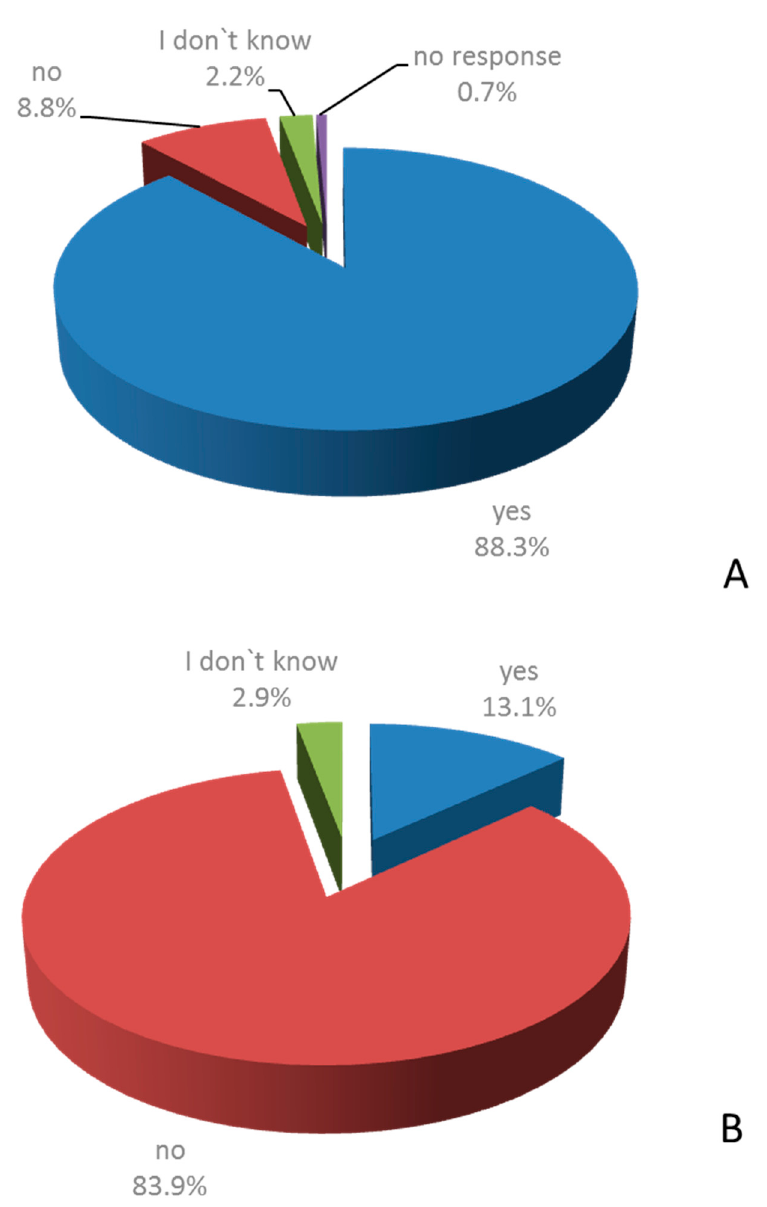
Figure 3. Agreement with statements on SUP in the clinical routine. Staff members were asked whether they agree or disagree with the following statements: “My decision on the prescription of SUP is based on my evaluation of the individual risk of the patients for stress ulcer bleeding” ( A ) and “Due to the high incidence of preventable gastrointestinal bleeding from stress ulcers I prescribe SUP to every hospitalized patient.” ( B ) ( n = 137) .